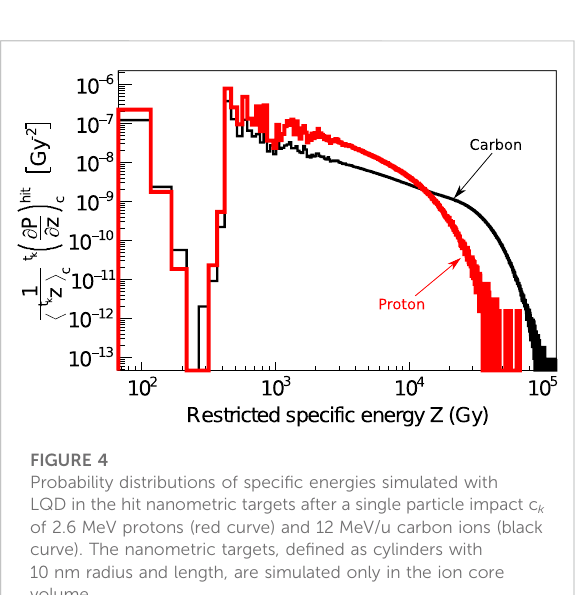
FIGURE 4 Probability distributions of speci fi c energies simulated with LQD in the hit nanometric targets after a single particle impact c k of 2.6 MeV protons (red curve) and 12 MeV/u carbon ions (black curve). The nanometric targets, de fi ned as cylinders with 10 nm radius and length, are simulated only in the ion core